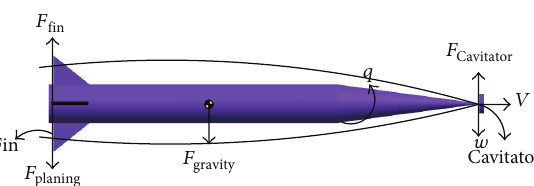
Figure 1: Shape and force diagram of the supercavitating vehicle.